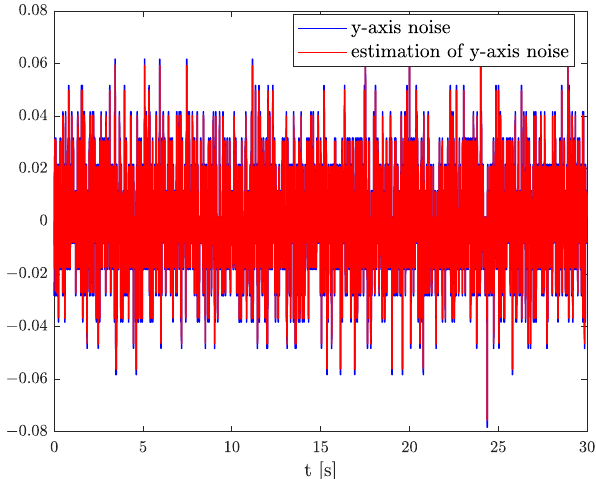
Figure 15. Original and estimation of y -axis